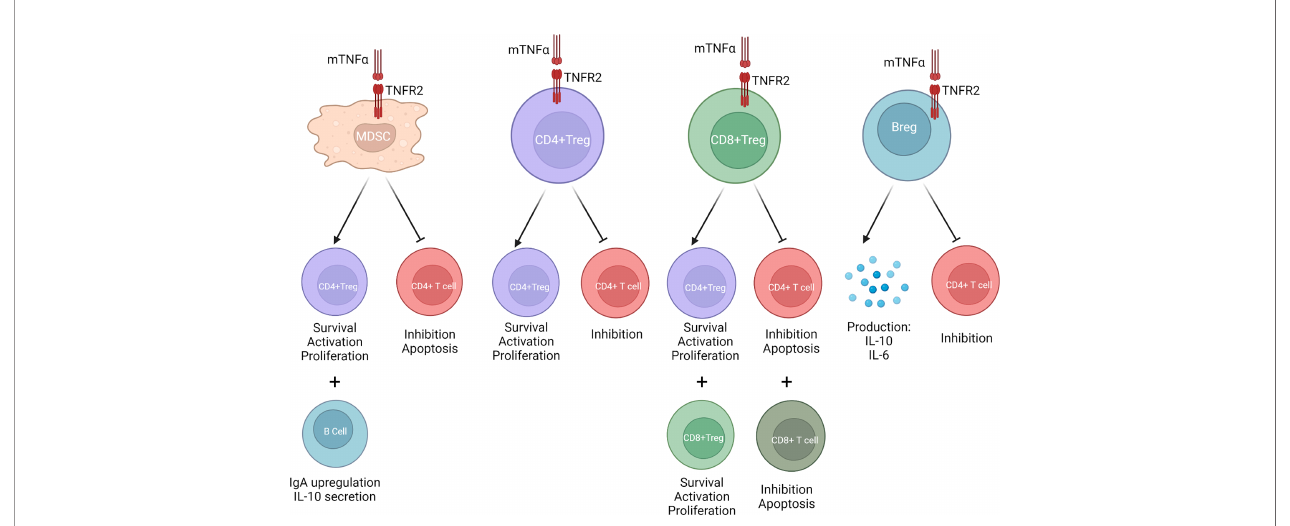
FIGURE 1 | When mTNF a binds to TNFR2, MDSCs, CD4+Tregs, CD8+Tregs, and Bregs are activated. This increases CD4+Treg and CD8+Treg stability and expansion. It stimulates production of anti-in fl ammatory cytokines such as IL-10 and TGF- b . It inhibits CD4+ T effector cell function. It promotes upregulation of immunoglobulin A (IgA) B